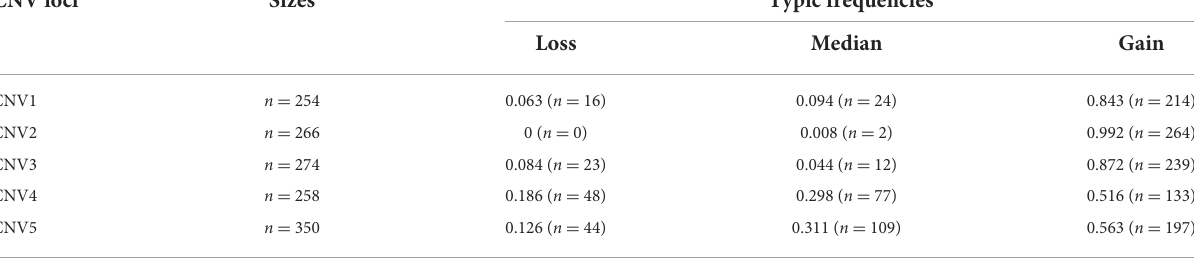
TABLE 2 Typical frequencies of copy number variations within the SNX29 gene in SBWC goats. CNV loci Sizes